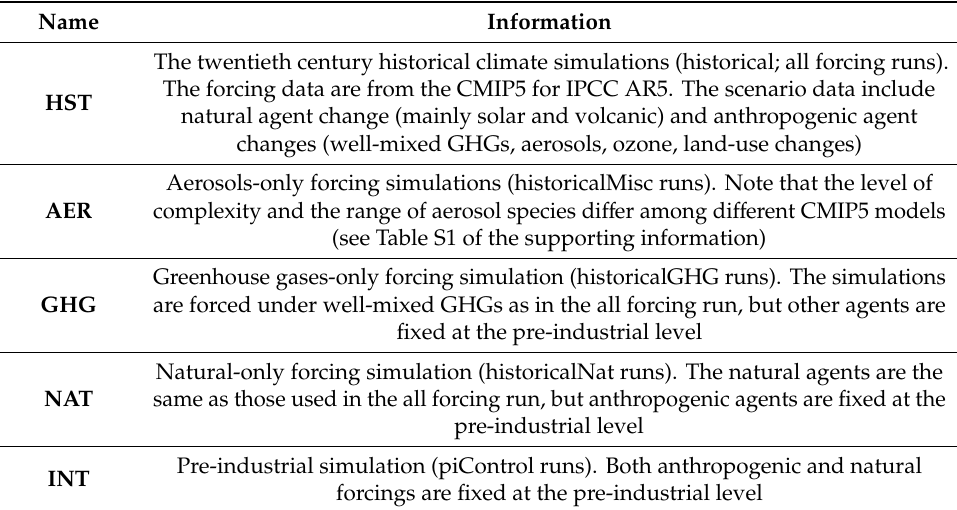
Table 2. Five sets of climate simulations are used in this